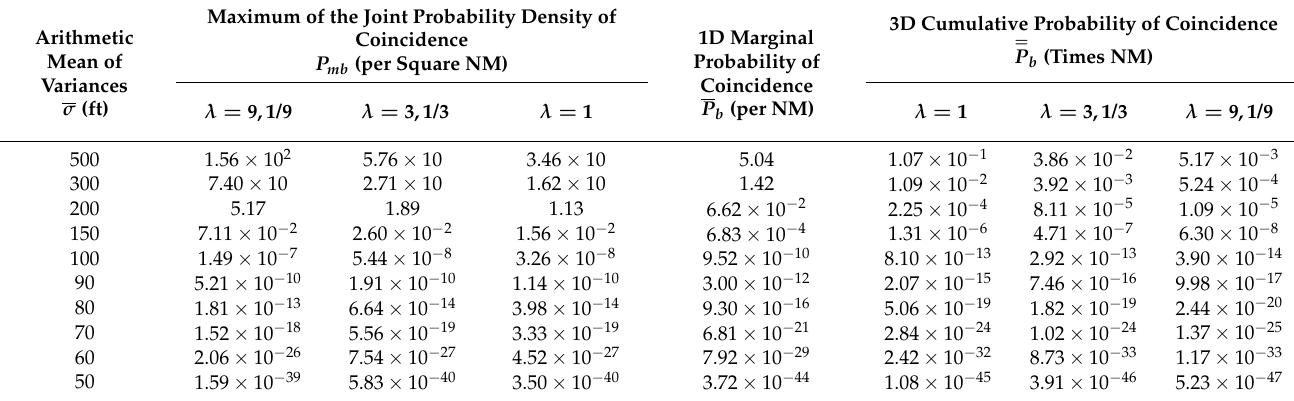
Table 3. Upper bound to probabilities of collision assuming Gaussian probability distribution with vertical separation L b = 1000 ft. See Table 2 for a reduced vertical separation L b = 1000